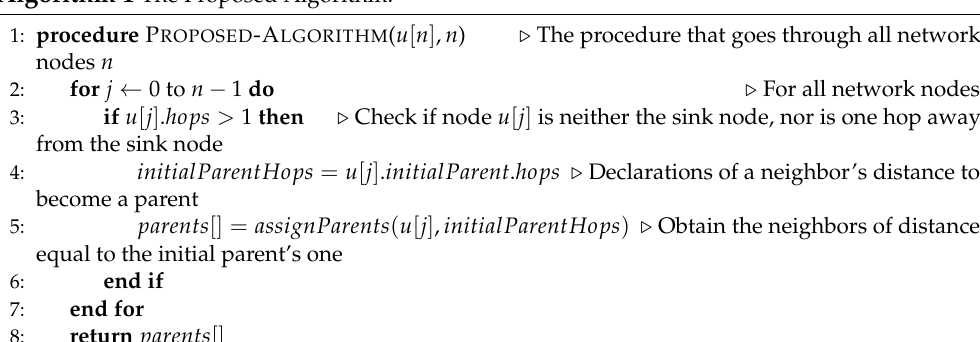
Algorithm 1 The Proposed Algorithm.